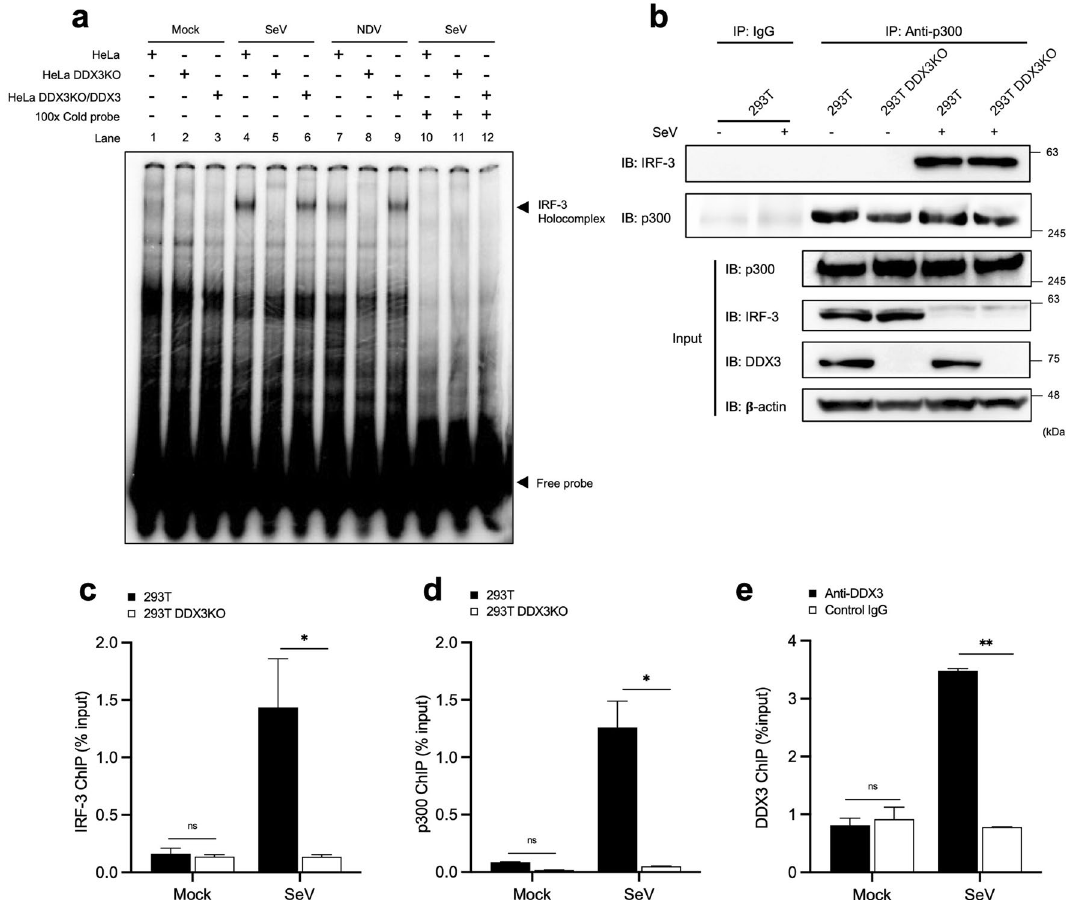
Figure 5. DDX3 is dispensable for the formation of a complex composed of IRF-3 and p300, but essential for its specific binding to the IRF motif DNA sequence. ( a ) HeLa, HeLa DDX3KO, or HeLa DDX3KO/DDX3 cells were transiently transfected with the expression vector for IRF-3 and mock treated or infected with SeV or NDV as indicated. Nuclear extract was prepared and subjected to EMSA with γ 32 P -labeled oligonucleotides containing the IRF-binding sequence. Unlabeled IRF-oligonucleotides (100-fold excess) were included to examine binding specificity (lanes 10–12). ( b ) 293T or 293T DDX3KO cells were infected with SeV for 12 h. Whole cell lysates were subjected to immunoblotting for p300, IRF-3, DDX3, or β-actin (input). Whole cell lysates were immunoprecipitated by control antibody (IgG) or anti-p300 and the precipitates were analyzed by immunoblotting for IRF-3 or p300. Full-length gels in Supplementary Information. ( c ) ChIP-qPCR assays of 293T and 293T DDX3KO cells stimulated by infection with SeV for 12 h. Chromatin was immunoprecipitated with anti IRF-3 antibody. ( d ) ChIP-qPCR assay as in ( c ) except with immunoprecipitation by anti p300 antibody. ( e ) ChIP-qPCR assay as in ( c ) but except with immunoprecipitation by control IgG or anti DDX3. Data are indicated as % of the DNA input. Data are presented as the mean ± SEM and are one representative of two independent experiments. Data were analyzed using two-way ANOVA with Sidak’s post-test ( c – e ). * p < 0.05, ** p < 0.001. ns, not